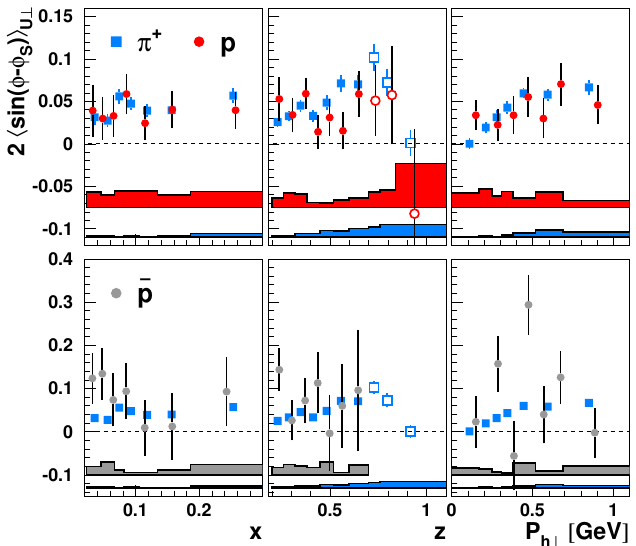
Figure 17 . Comparison of Sivers SFA for positive pions and protons (upper plot) or antiprotons (lower plot) presented either in bins of x , z , or P h ⊥ . Data at large values of z , marked by open points in the z projection, are not included in the other projections (no such high- z points are available for antiprotons due to a lack of precision). Systematic uncertainties are given as bands, not including the additional scale uncertainty of 7.3% due to the precision of the target-polarization